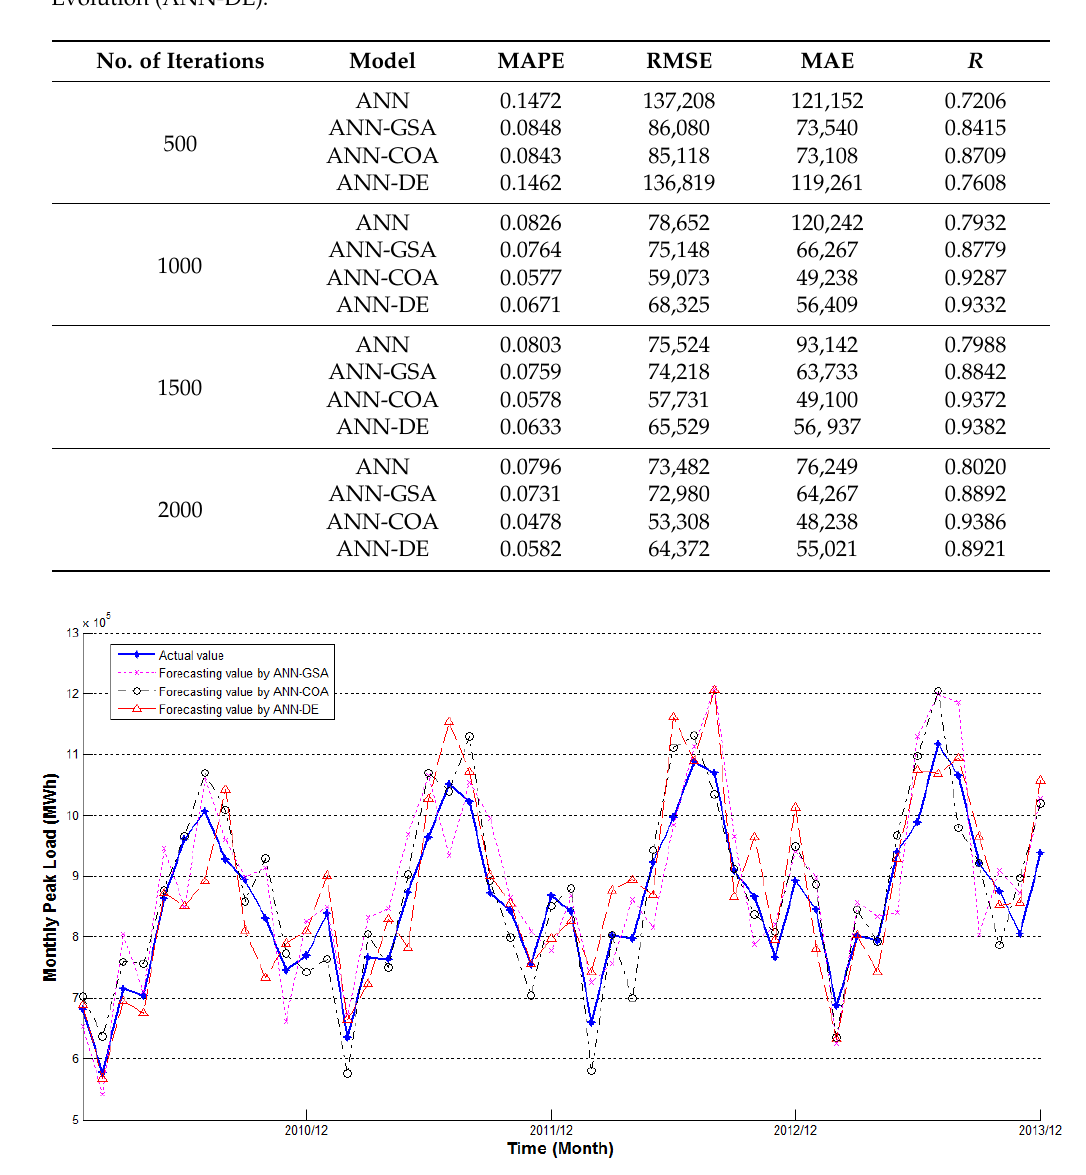
Figure 7. The forecasting performance of Artificial Neural Network trained by Gravitational Search Algorithm (ANN-GSA), Artificial Neural Network trained by Cuckoo Optimization Algorithm (ANN-COA), and Artificial Neural Network trained by Differential Evolution (ANN-DE).